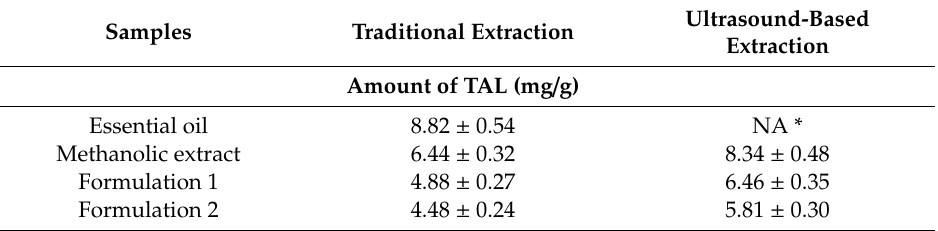
Table 5. Quantitative analysis of TAL in essential oil, methanolic extract and commercial formulations